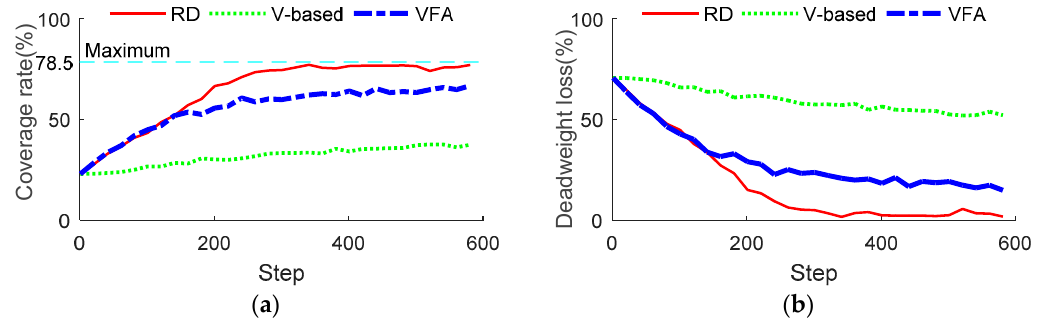
Figure 19. The comparison of coverage rate and deadweight loss. ( a ) Comparison of coverage rate; ( b ) Comparison of deadweight loss.